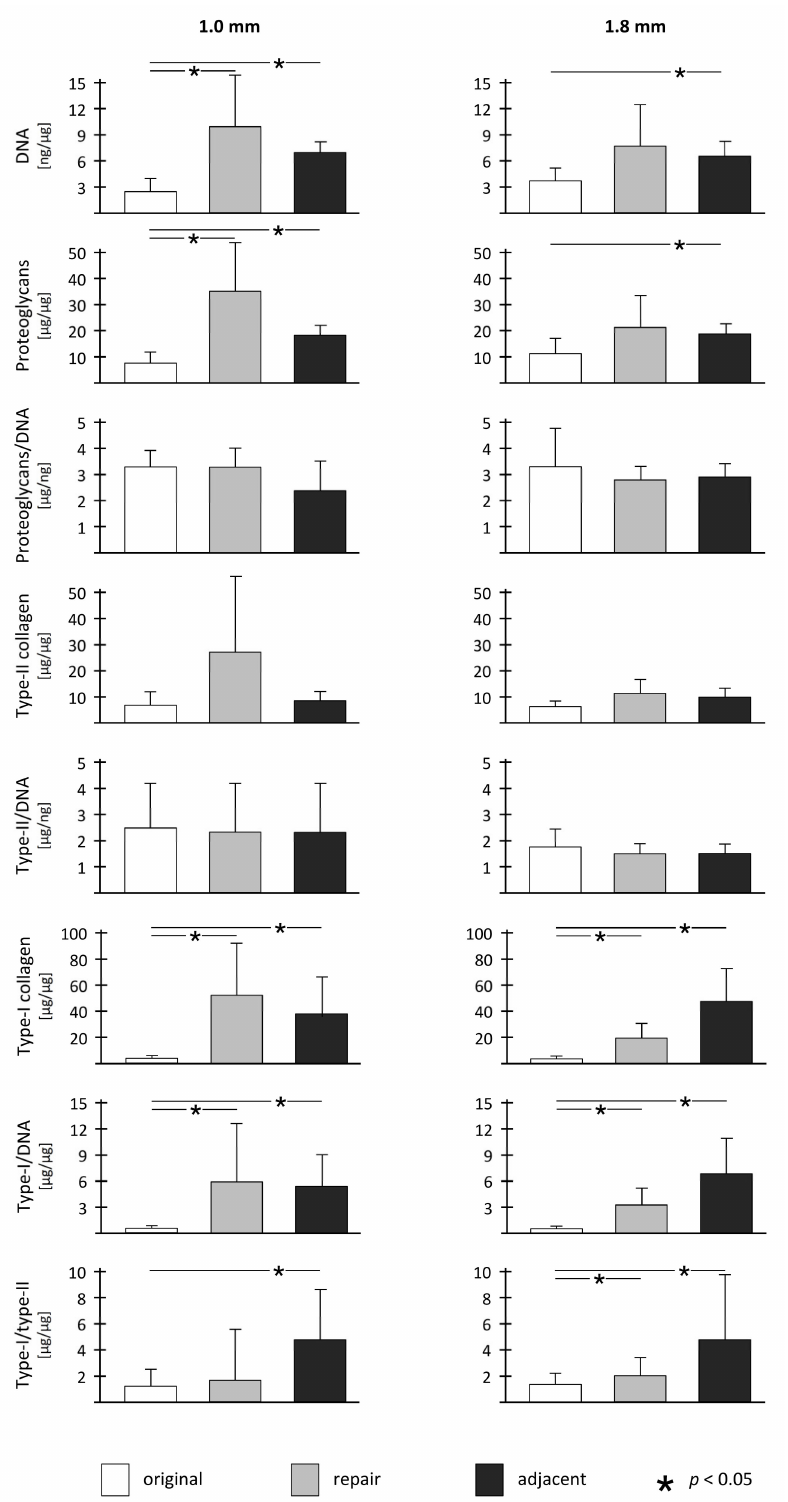
Figure 3. Overview of biochemical parameters and statistical comparison between original cartilage, repair cartilage, and adjacent cartilage within both treatment